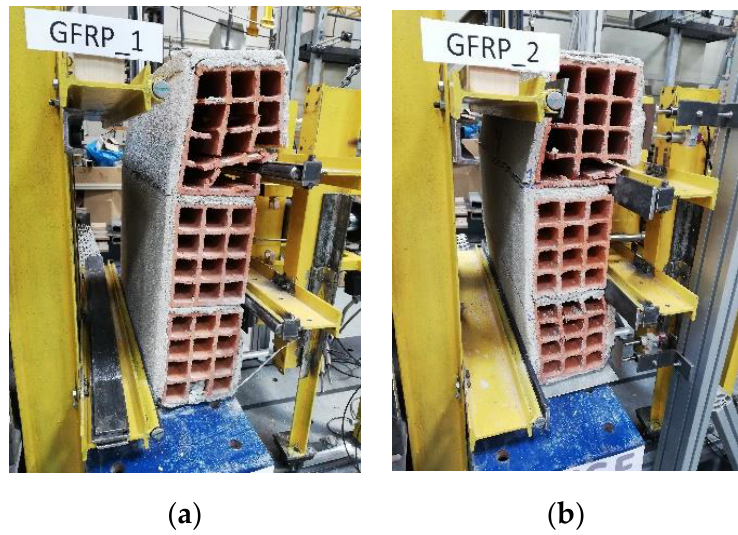
Figure 6. Damages observed ( a ) Specimen 1 and ( b ) Specimen 2.